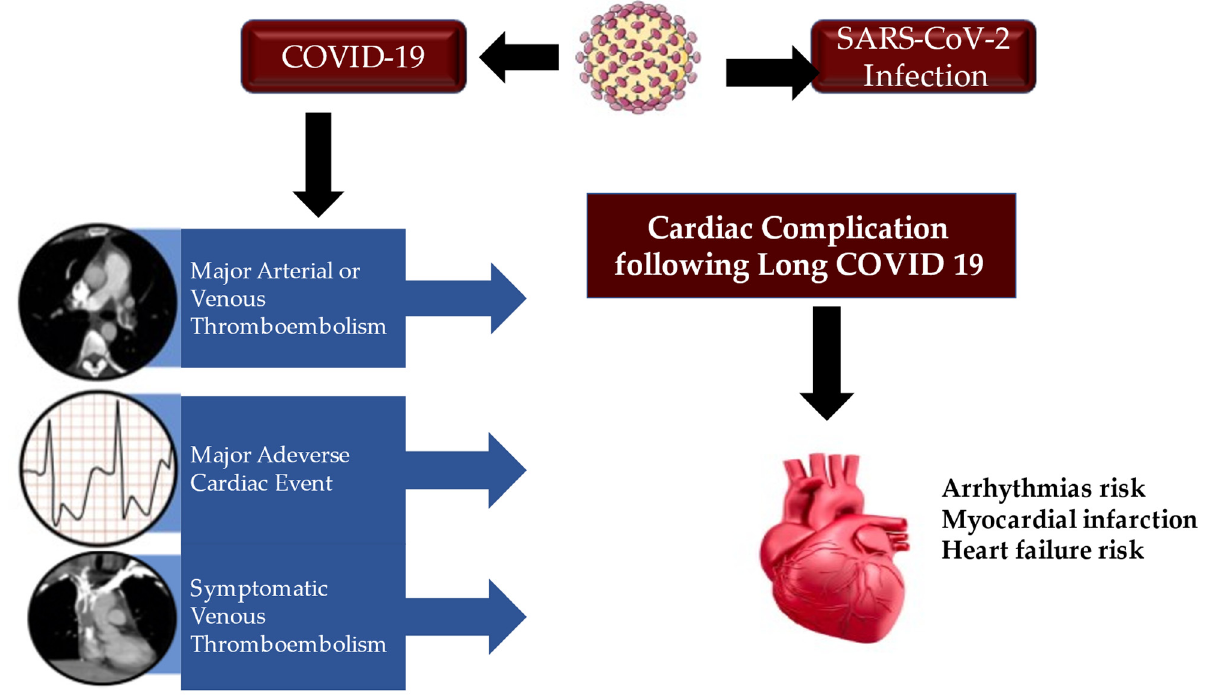
Figure 6. The acute clinical manifestations of COVID-19 are well-characterized by inflammatory response, endothelial dysfunction and overlapping infection that can evolve into major arterial and venous thromboembolism, major adverse cardiac event, and symptomatic venous thromboembolism. In COVID, heart condition patients may reveal a range of increased cardiovascular risks. Abbreviations: COVID-19: coronavirus disease 2019; SARS-CoV-2: severe acute respiratory syndrome-coronavirus-2.